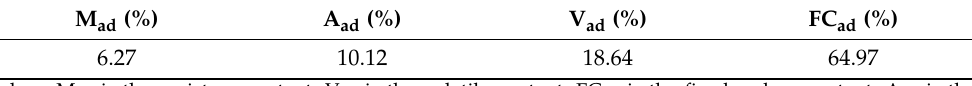
Table 1. Proximate analysis of coal sample (air-dried).